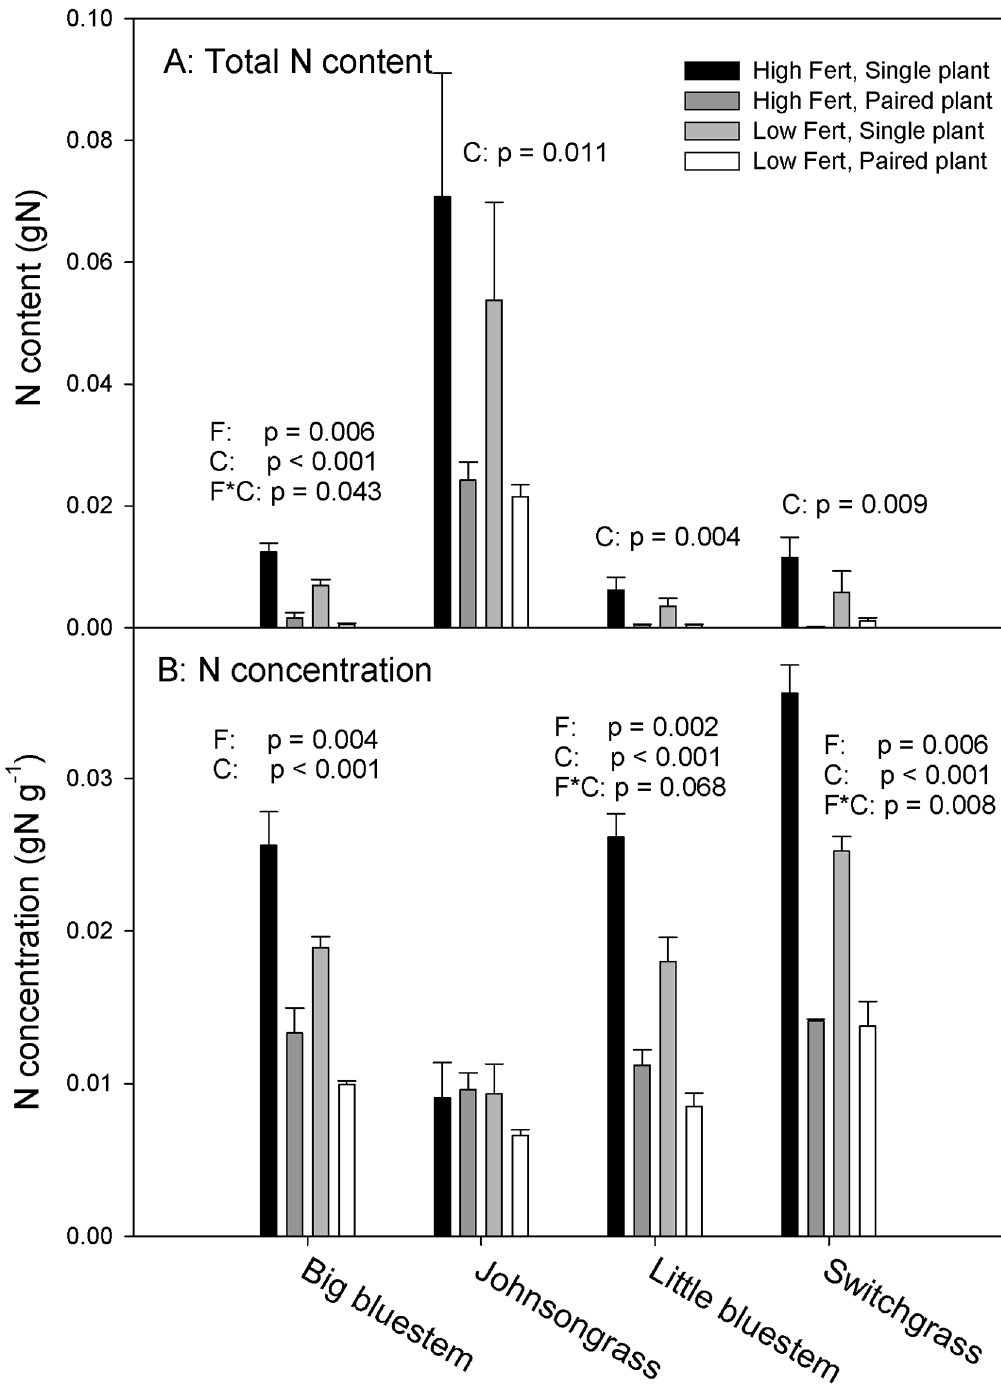
Fig 4. Total nitrogen content and nitrogen concentration in above-ground biomass at first harvest. Error bars reflect one standard error of the mean. The p-valuesof statisticallysignificantor marginally significanteffects are summarized by species in each panel. Letter symbols stand for the effects of fertilizer (F), competition(C) and their interaction (F * C).